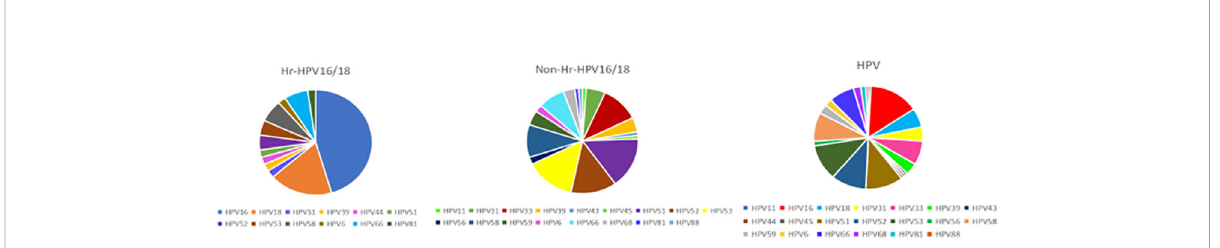
FIGURE 1 Prevalence of different HPV subtypes in infected groups. Hr-HPV16/18 (n = 28): HPV16/18 high-risk infection group; non-Hr-HPV16/18 (n = 62): non-HPV16/18 high-risk infection group; HPV: HPV-infected group (n =